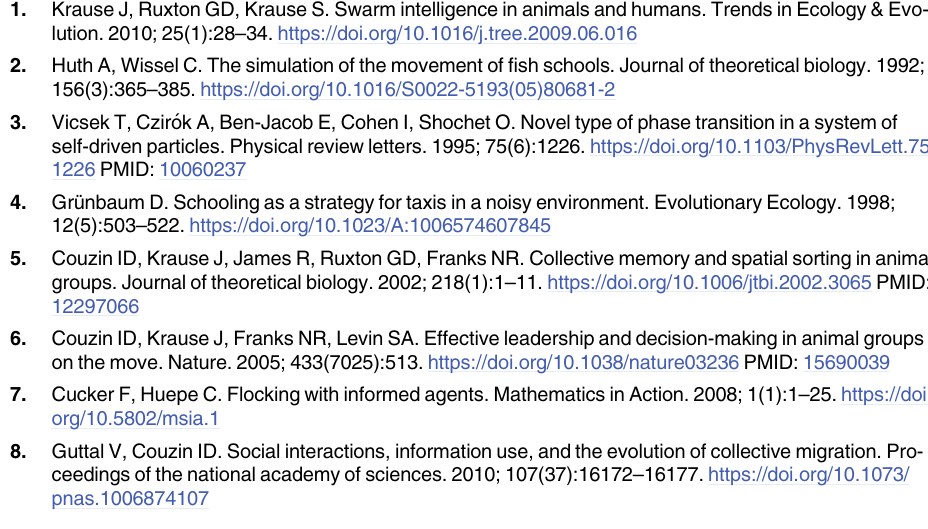
S9 Fig. Robustness of the general results for C and A vs k with respect to variation of model parameters. The panels show results for changing individual model parameters by a factor of 2 (left columns) and 0.5 (right columns). Different rows represent variation of differ- ent parameters, from top to bottom: v the default parameters: v